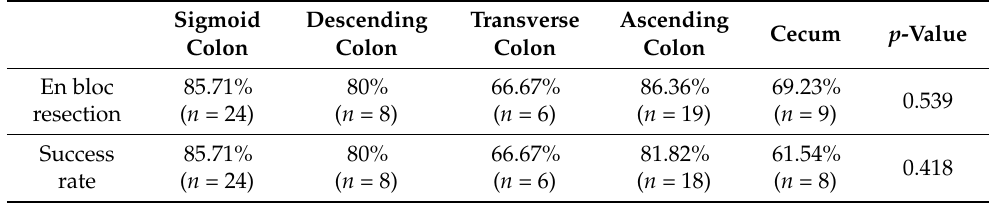
Table 4. Efficacy of ESD procedure in lesion <50 mm with LGD according to location of the